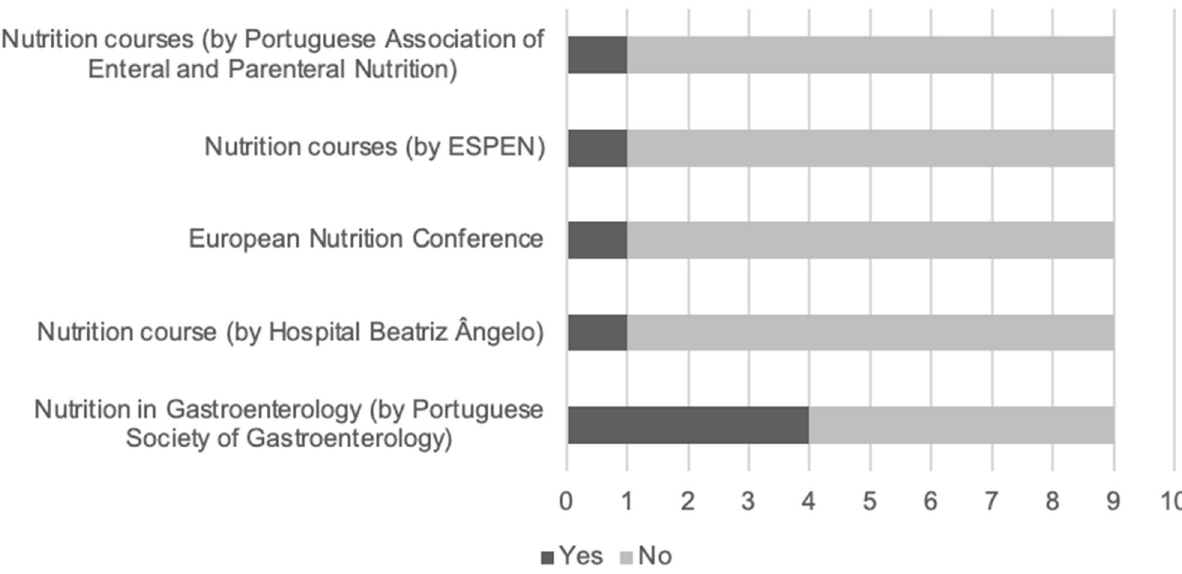
Figure 1. Nutrition ‐ related courses by number of departments. Figure 1. Nutrition-related courses by number of